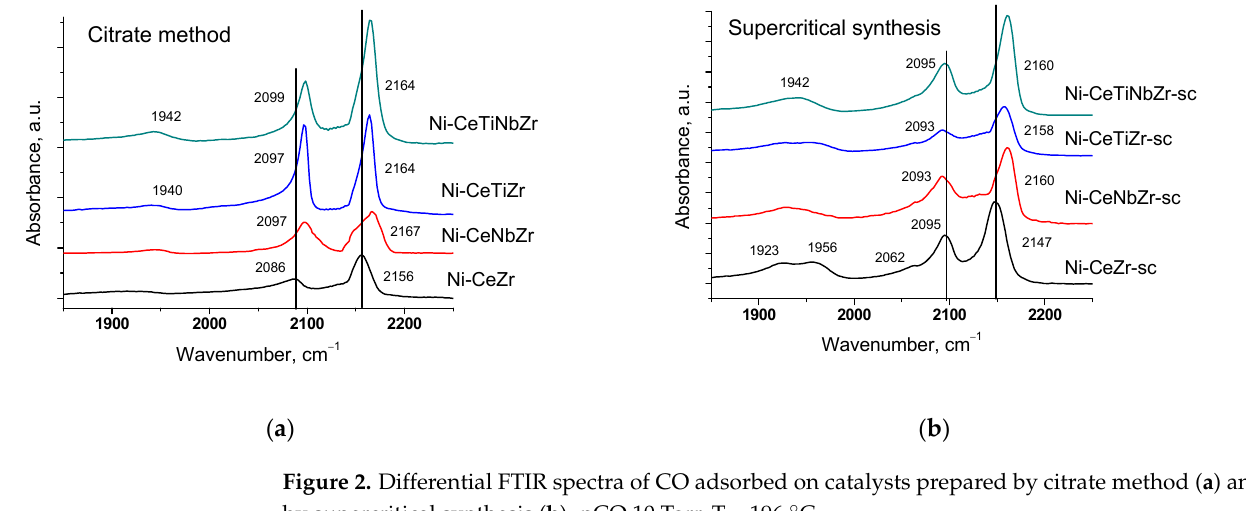
Figure 2. Differential FTIR spectra of CO adsorbed on catalysts prepared by citrate method ( a ) and by supercritical synthesis ( b ). pCO 10 Torr, T − 196 °C.